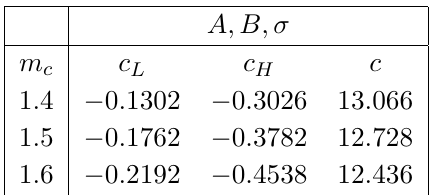
Table 1 . The coefficients c L , c H , and c for e + e − → J/ψ + η c at is GeV.